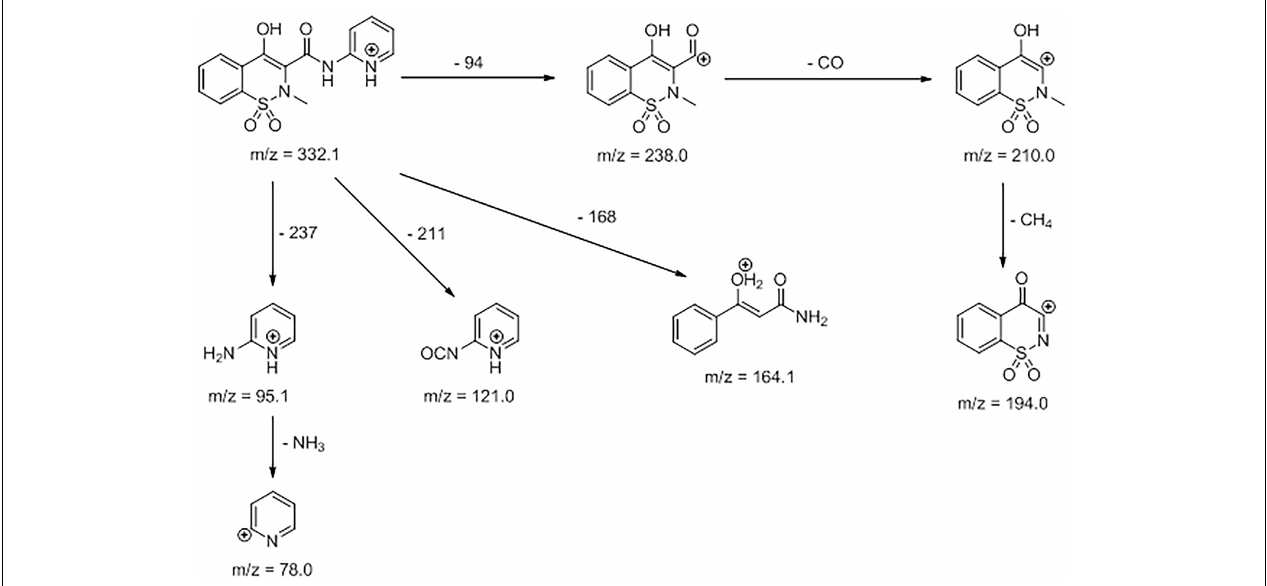
Frontiers in Microbiology |